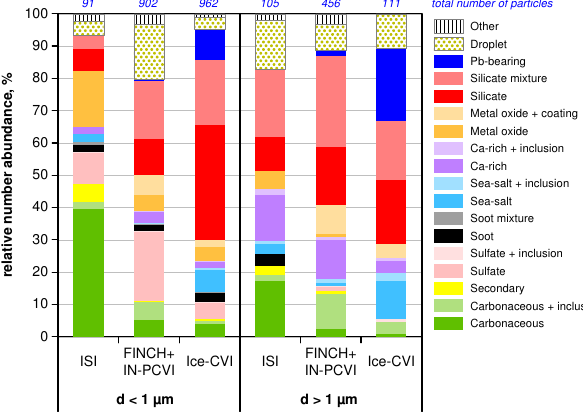
Figure 4. Relative number abundance (integrated over all samples) of different particle groups as function of sampling technique and particle size. The total number of analyzed particles is shown above the bars. For confidence intervals see Tables S2 and S3 in the Sup-